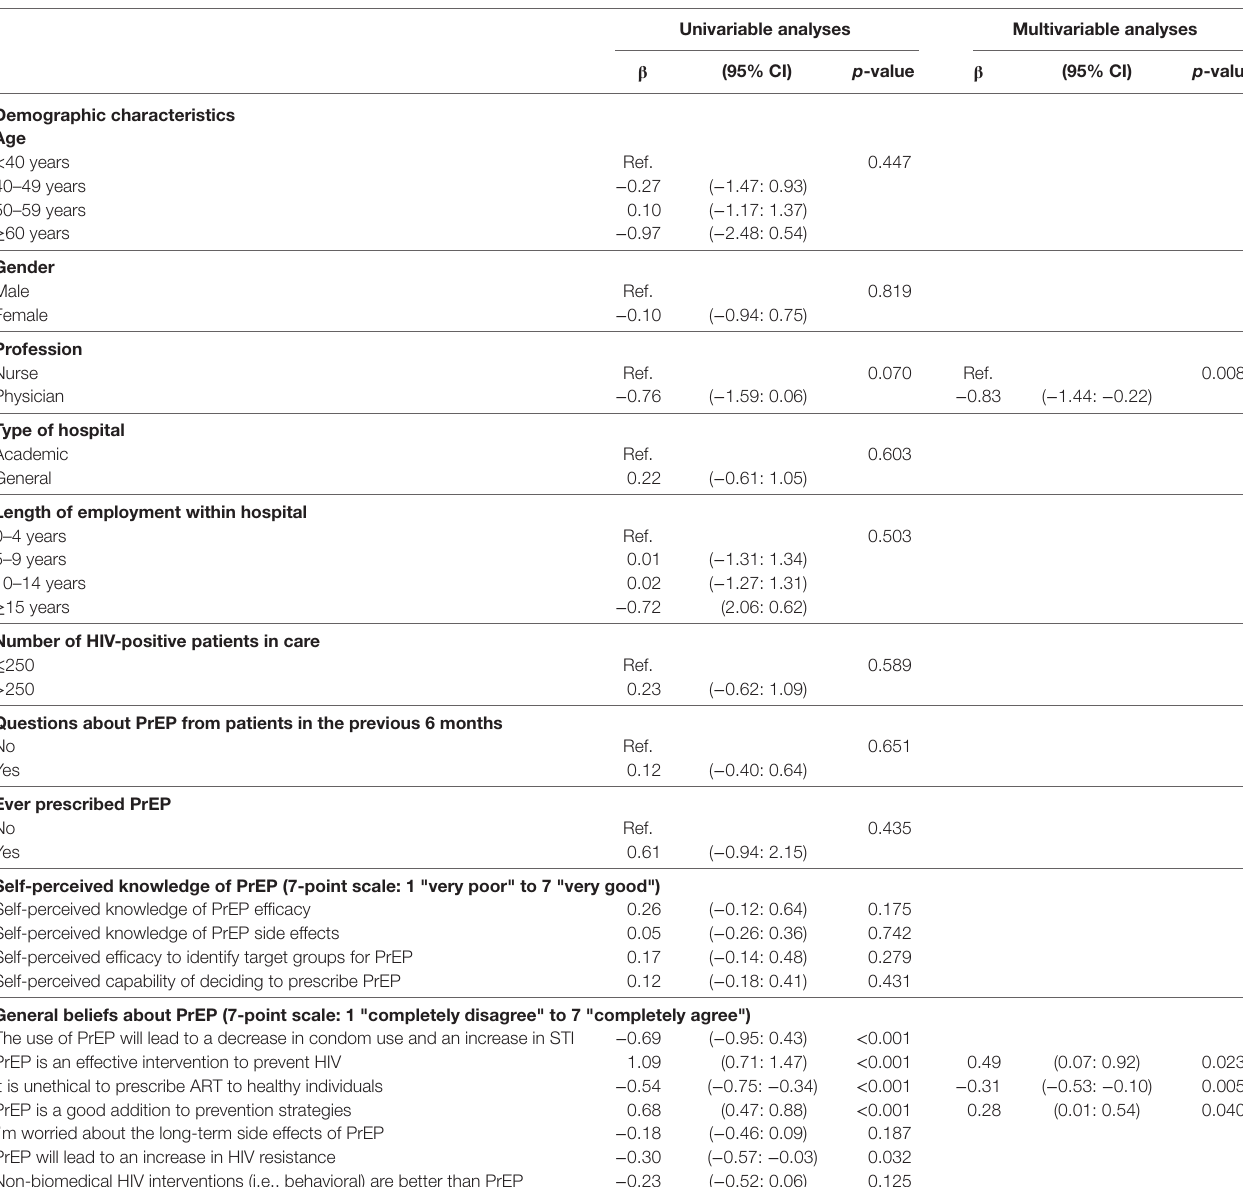
TaBle 4 | Determinants of acceptability of PrEP implementation in the Netherlands among 66 HIV specialists in the Netherlands (2015). Univariable analyses Multivariable